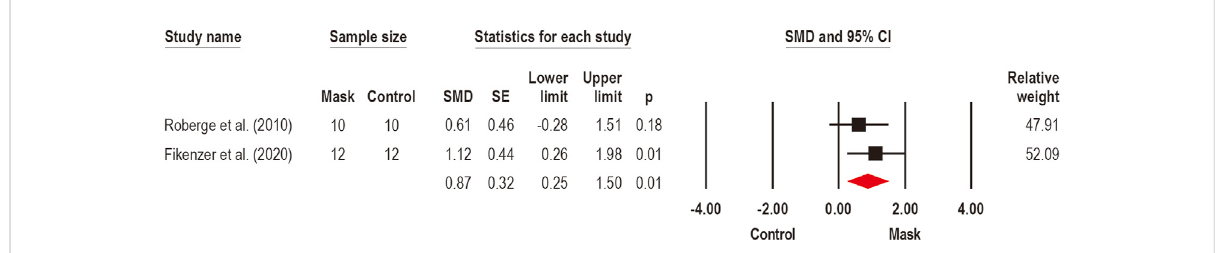
FIGURE 2 Acute effects of face mask vs. control (unmasked condition) on discomfort. Forest plots with pooled standardized mean difference (SMD), standard errors (SE), and 95% con fi dence intervals (CI) are displayed: (SMD: 0.87; 95% CI 0.25 – 1.5; p = 0.01; I 2 =